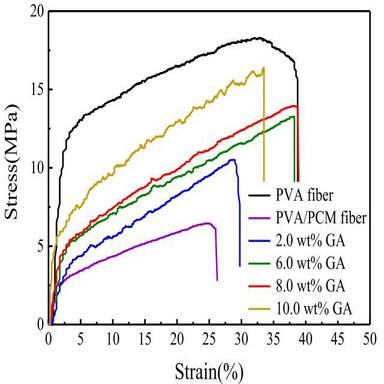
Stress–strain curves of different nanofiber samples.